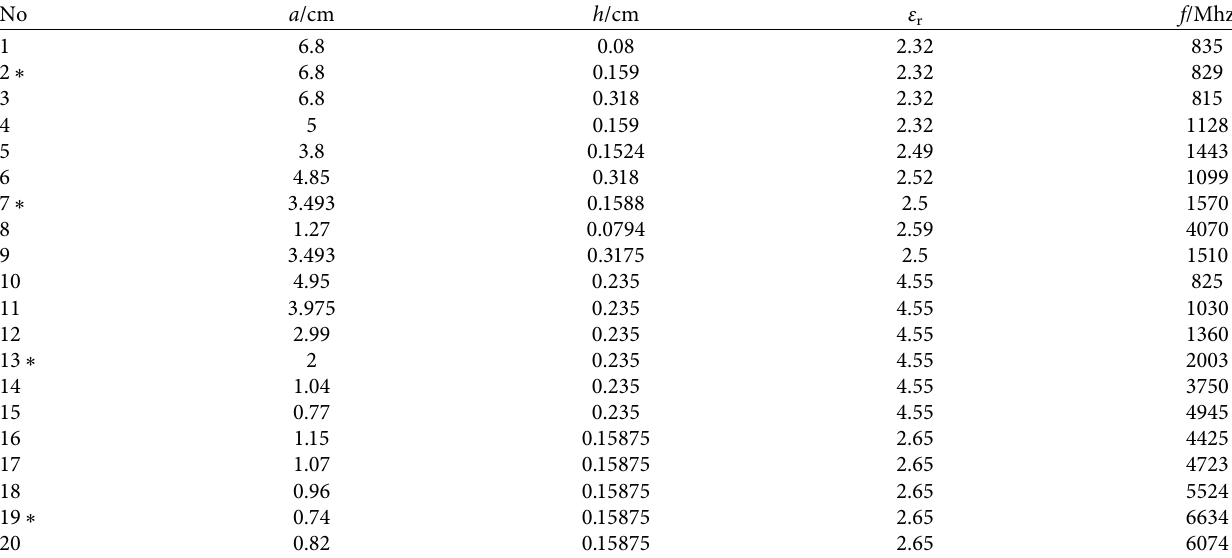
Table 4: Resonant frequency of CMSA for TM11